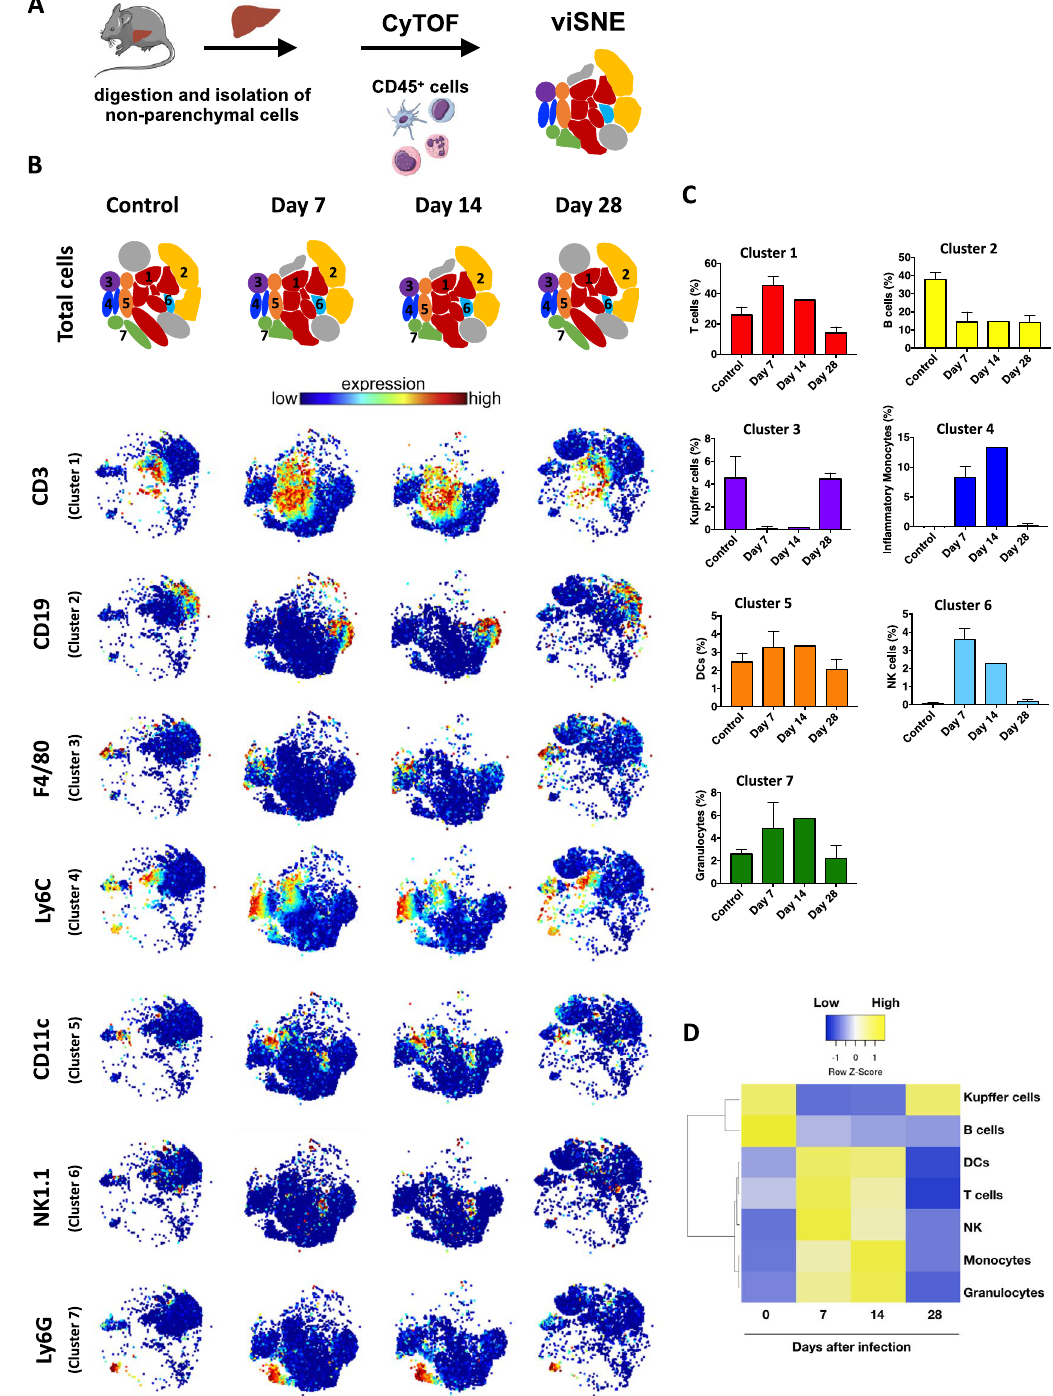
Figure 2. Identification of liver immune cells by CyTOF. ( A ) Schematic representation of liver nonparenchymal cells and clustering after CyTOF Cytobank analysis. The scheme was partly generated using Sevier Medical Art, provided by Sevier, licensed under a Creative Commons Attribution 3.0 unported license. ( B ) Representation of viSNE analysis showing clusters and the expression of several different surface markers that enable the distinction of immune populations. ( C ) Representative bar graph indicating the frequencies of immune cell populations. Data are represented as mean. ( D ) Heatmap illustrating the differential expression of cell population markers in different time points after